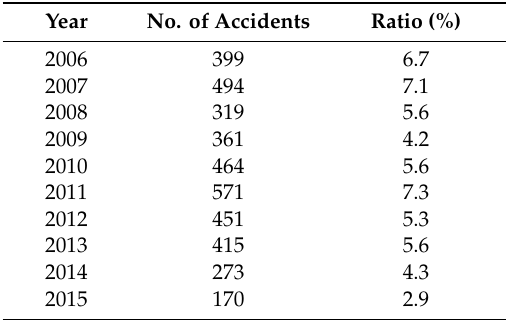
Table 1. The number of annual electrical equipment accidents caused by floods.